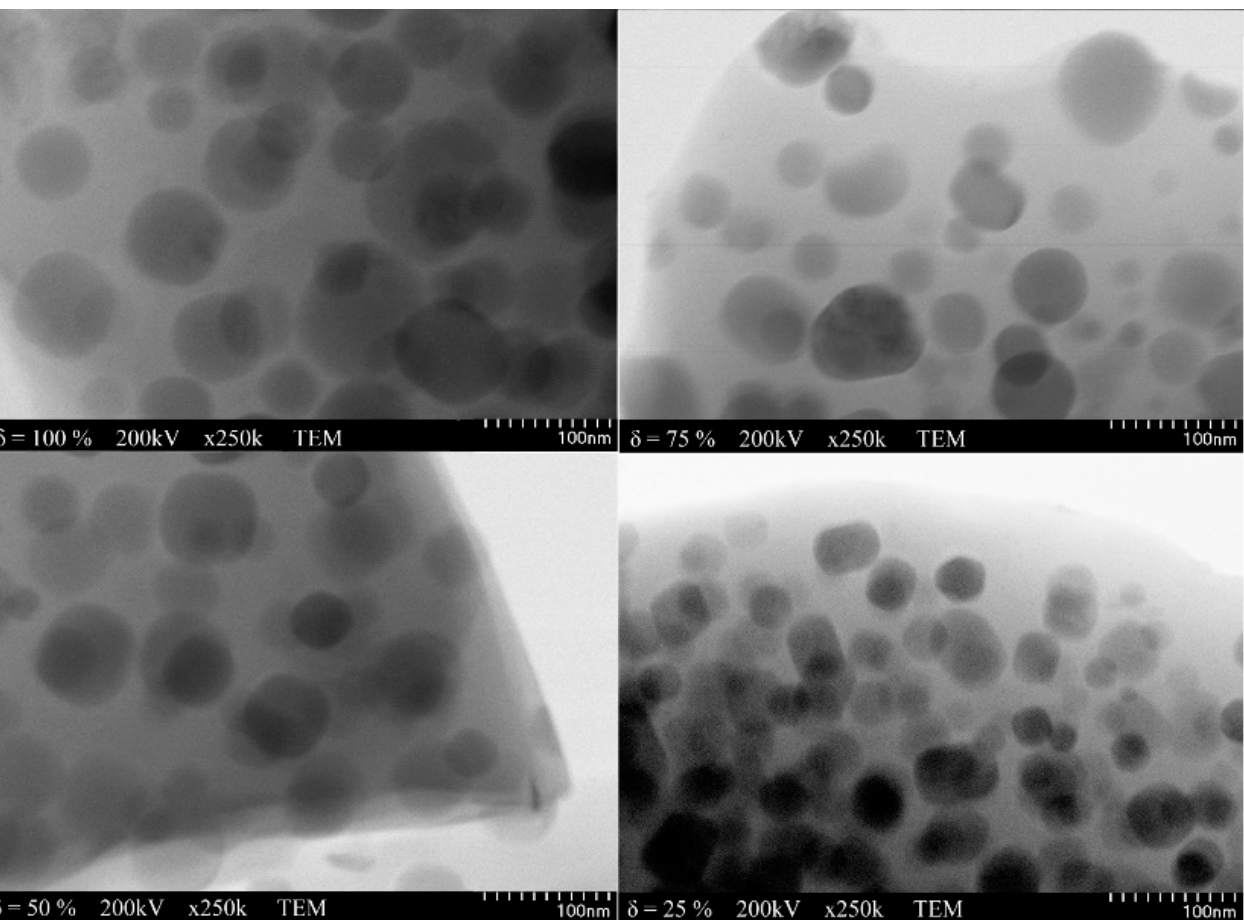
Figure 1. TEM images of (Zn 0.6 Mn 0.4 Fe 2 O 4 ) δ (SiO 2 ) 100 −δ NPs calcined at 1100 °C.